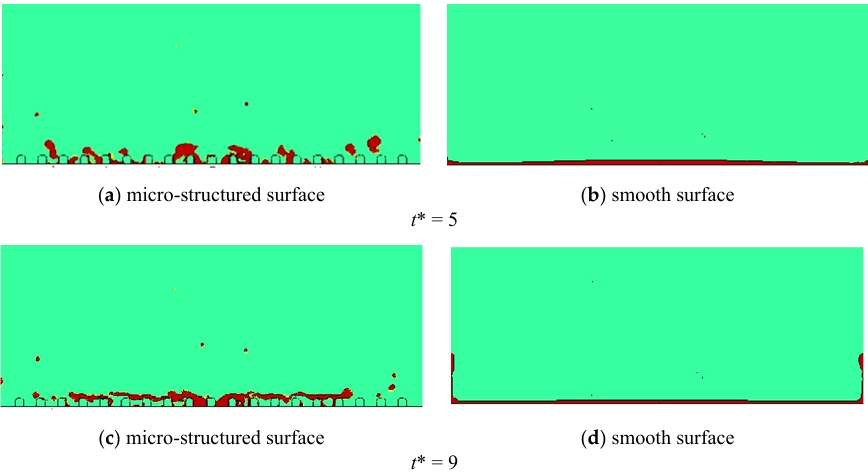
Figure 11. Comparison of liquid films formed by droplet impinging on smooth and micro-structured surface,